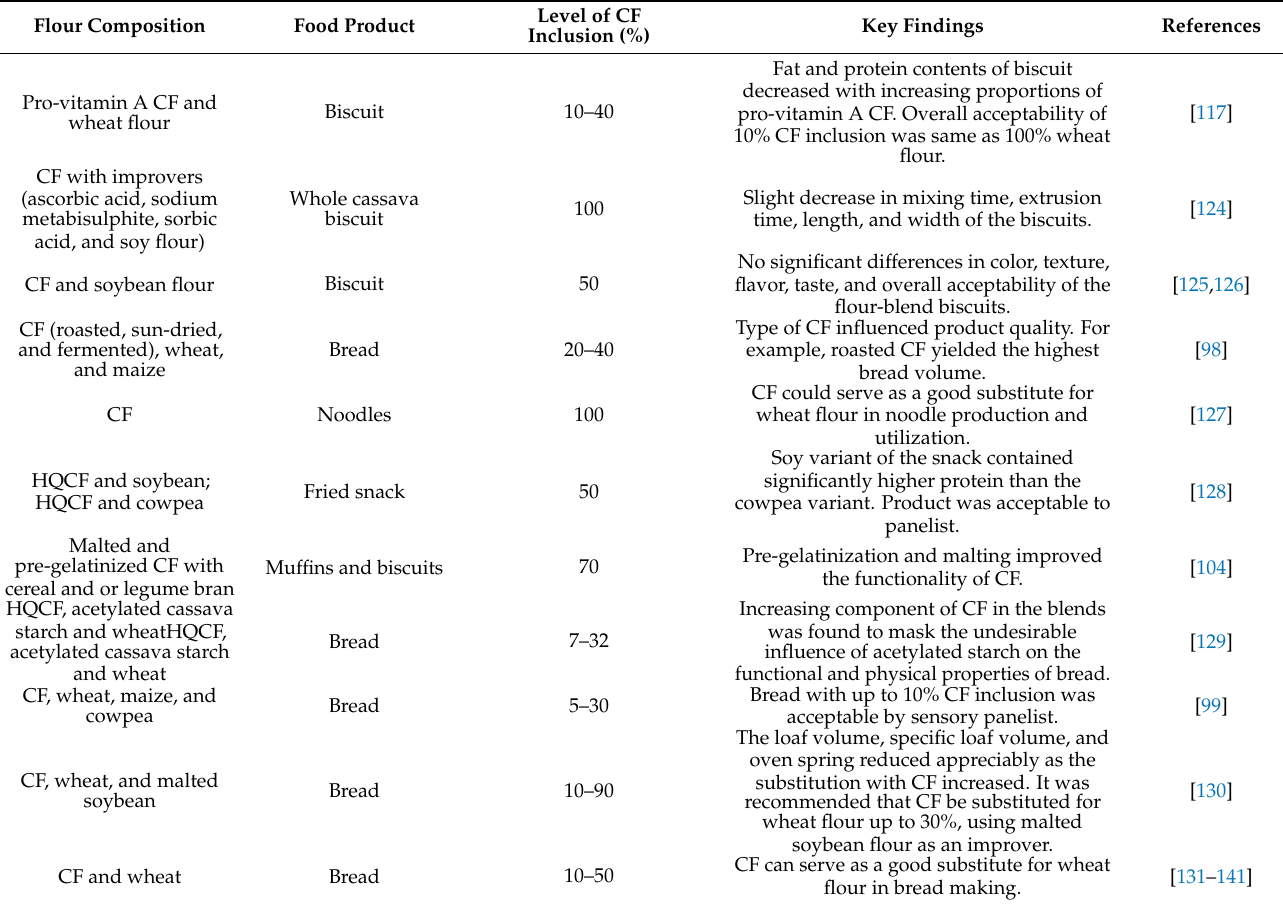
Table 4. Application of cassava flour (CF) in various flour-based food